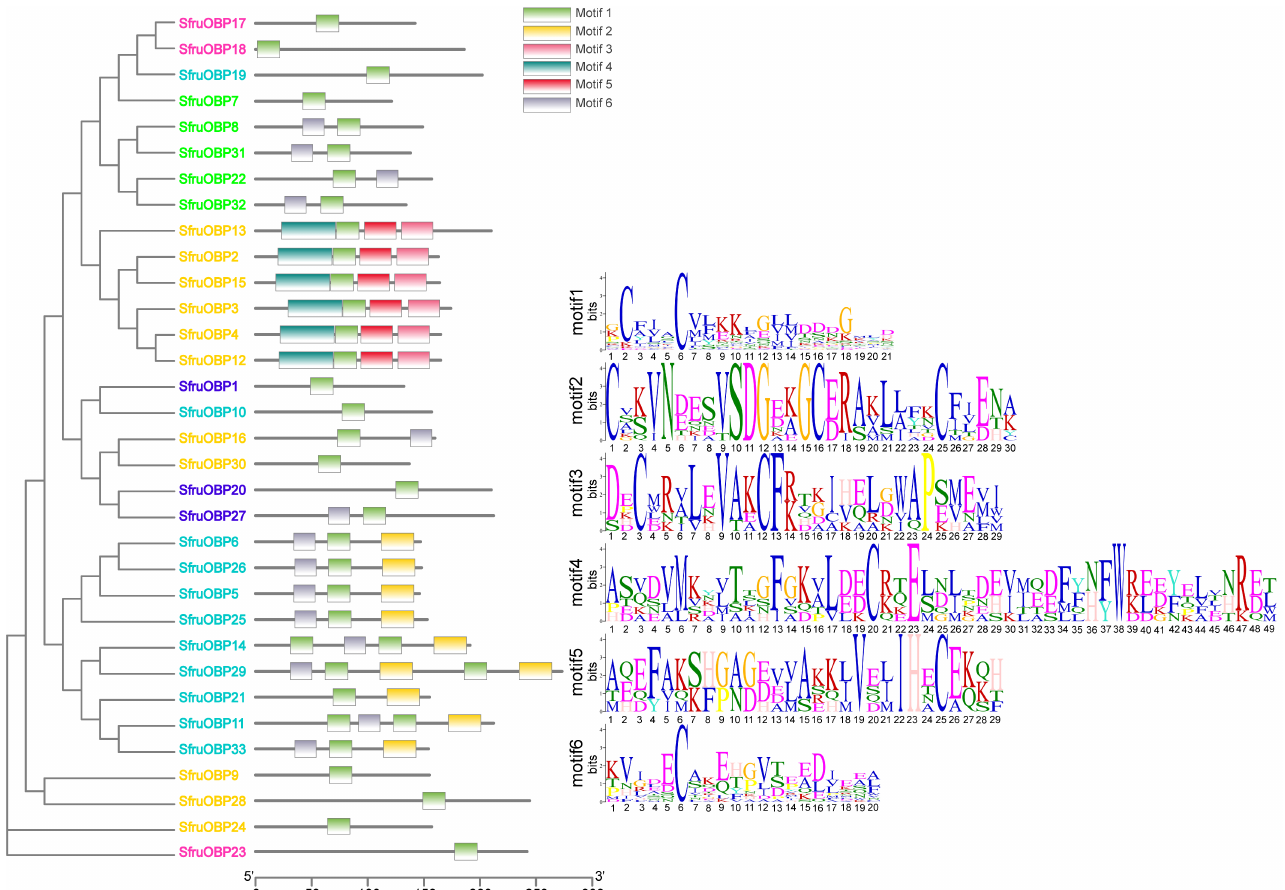
Figure 7. Motif distribution of SfruOBPs . Different motifs are represented by different colors, and the x ‐ axis represents the length of the proteins. The SeqLogo of motifs is predicted with the MEME online tool. Different colors of gene names indicate OBPs from specific Clusters as indicated in Figure 1: cyan, Cluster 1; pink, Cluster 2; bright green, Cluster 3; blue, Cluster 4; orange, Cluster 5.